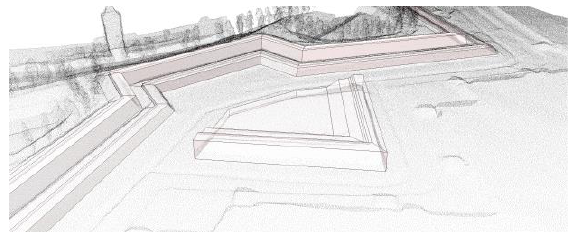
Figure 6. Reconstruction and point cloud fitting of bastioned fortification